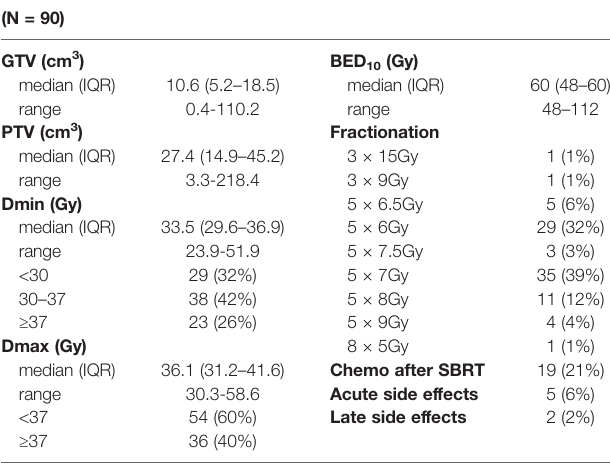
TABLE 2 | SBRT characteristics.